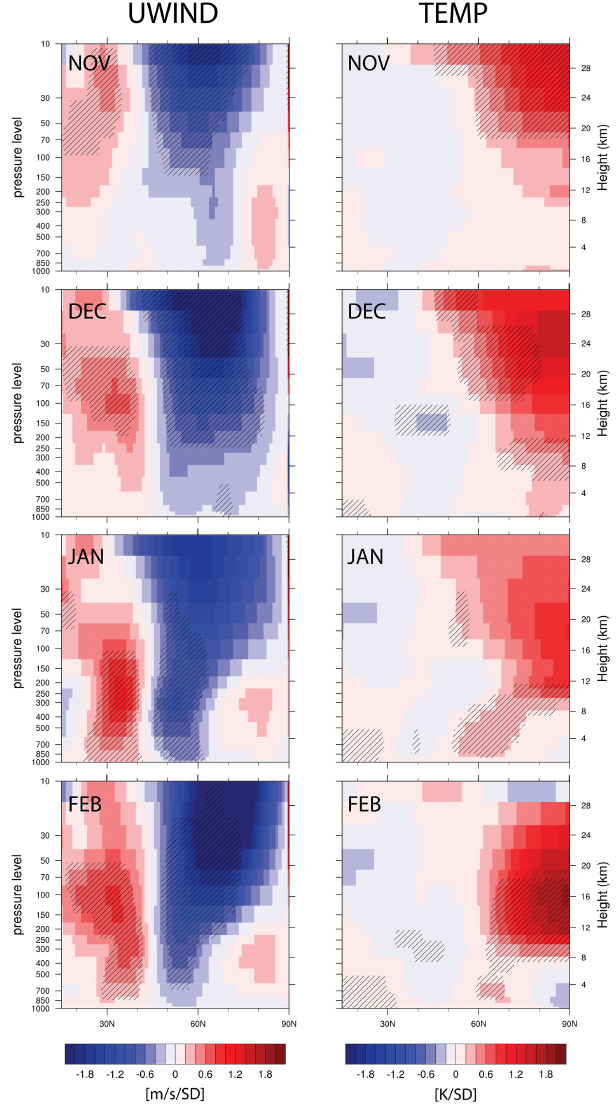
Figure 4. Zonal-mean meridional cross section of ERA20C anoma- lies in temperature and zonal wind regressed onto the snow dipole index in November from ERA20C covering 1901–2010 for Novem- ber, December, January and February. Shading indicates 95% sig- nificance level.